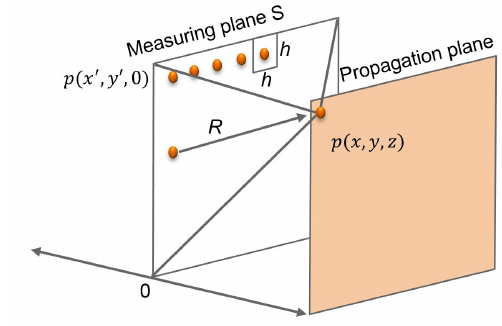
Figure 4. Schematic representation of the re-radiation